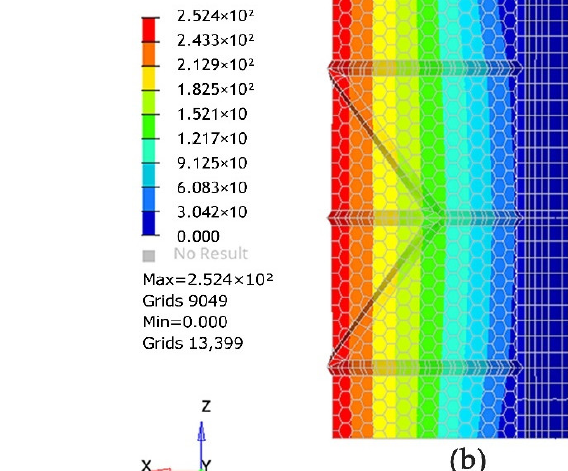
Figure 11. Stress diagram of model I rod under the action of permanent load plus external load. ( a ) Numerical diagrams of maximum tensile and compressive stresses for model I skeleton under self- weight plus external load. ( b ) Numerical diagram of maximum tensile and compressive stresses in model one skeleton with membrane cloth under self-weight plus external load. 3.1.2. Mechanical Comparison of the New Energy Vehicle Charging Post Carport Model II According to the bionic carport model II of the dragonfly wing structure, its maxi- mum deflection values under self-weight are shown in Figure 12; the maximum deflection values under self-weight plus an external load are shown in Figure 13; the stress nepho- gram under self-weight plus an external load is shown in Figure 14.